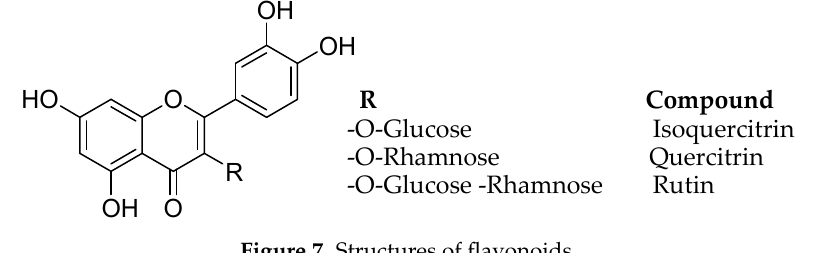
Figure 7. Structures of flavonoids.